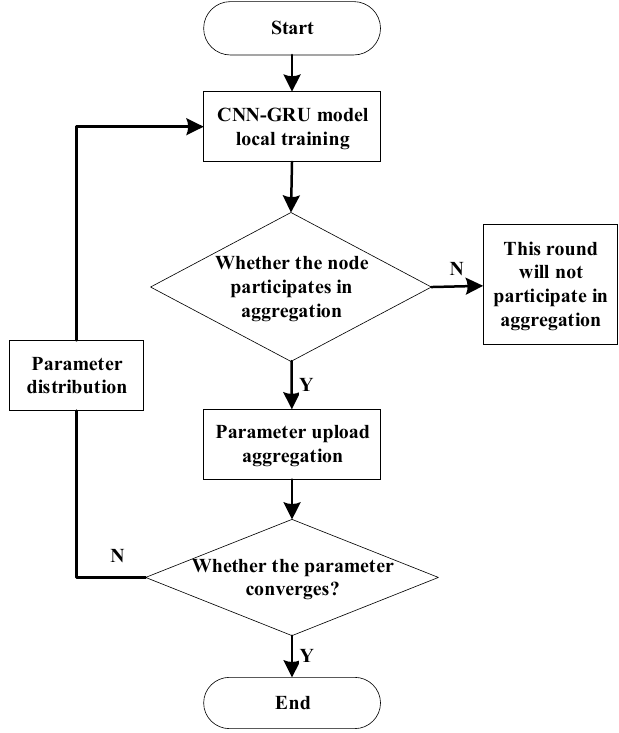
Figure 2. Horizontal FL process